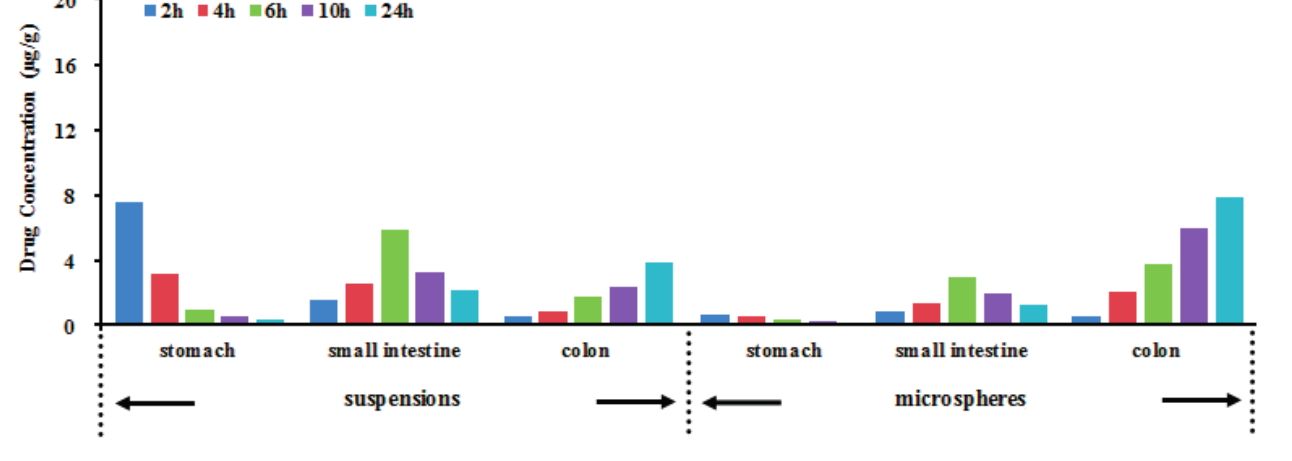
Figure 4. Distribution in tissue in rats following intragastric administration of a single 3.5 mg/kg dose of BUD suspensions and microspheres (each point represents the mean ± SD of six